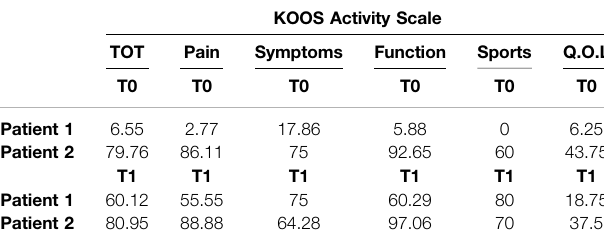
TABLE 2 | Results of the KOOS score and its domains at T0 and